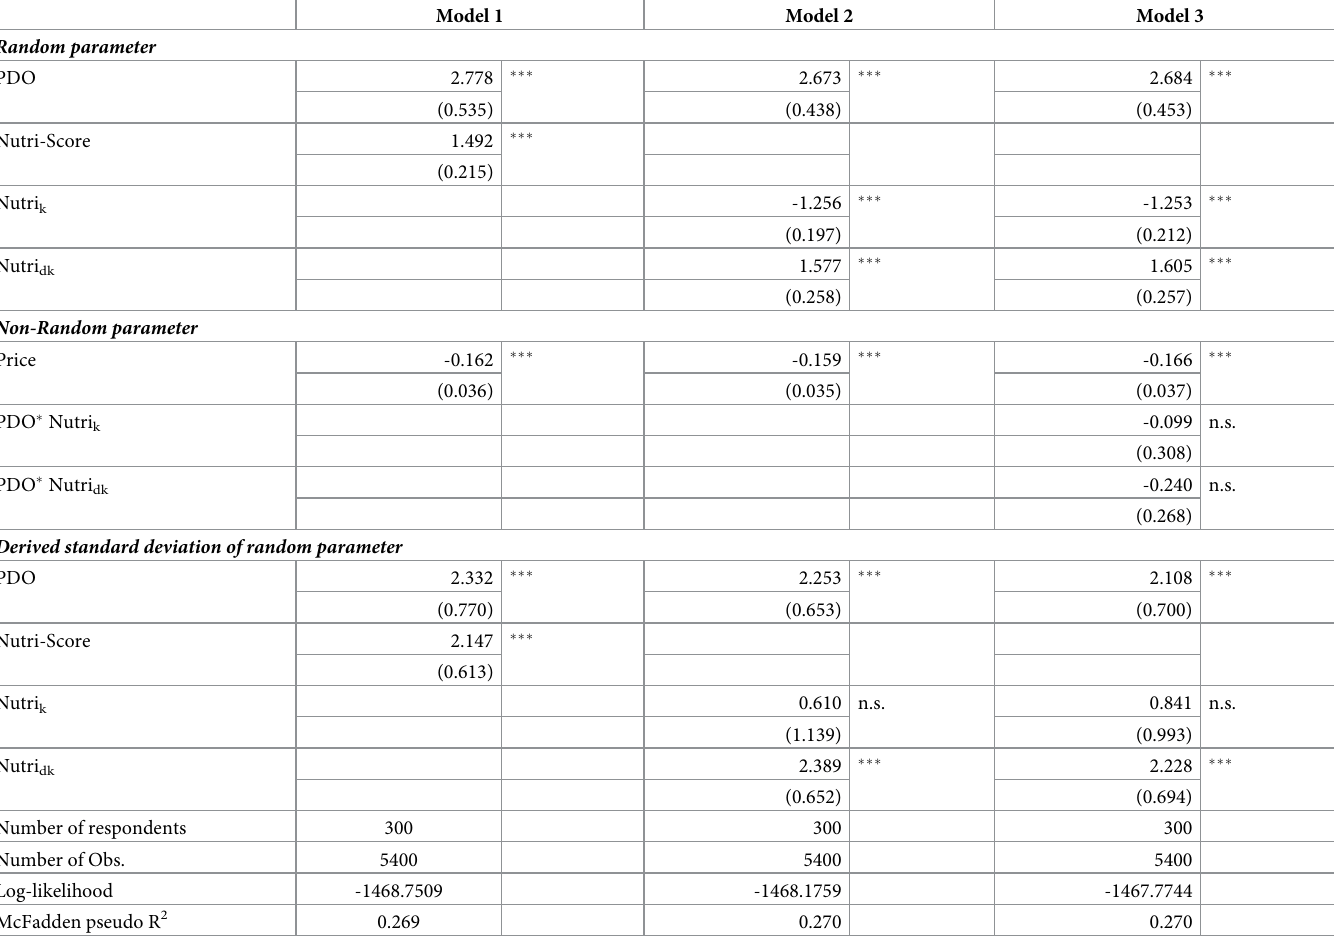
Table 5. Model estimates for the Fresh Asiago PDO and generic cheese of the same typology case